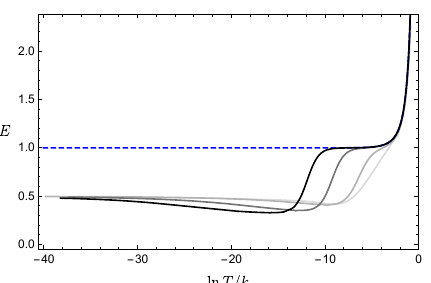
Figure 9 . Behaviour of the ratio of the thermal di(cid:11)usion constant to the butter(cid:13)y velocity, E (cid:17) D= ( v 2 = 2 (cid:25)T ), as a function of T for the black hole solutions constructed for m 2 = (cid:0) 15 = 4 and B (cid:24) = (cid:0) 1 = 4 and (cid:0) =k 3 = 2 (cid:21) (cid:22)(cid:0). For (cid:0) =k 3 = 2 = (cid:22)(cid:0), dashed blue line, we see E ! 1 as T ! 0. For the thermal insulators with (cid:0) =k 3 = 2 equal to 19 : 41, 19 : 75, 25 and 35 (dark grey to light grey), as in the right panels of (cid:12)gure 7 and 8, we see that E ! 1 = 2 as T !